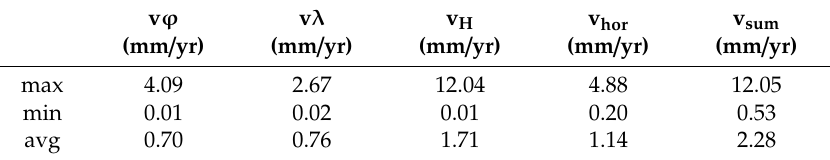
Table 3. The statistical value of the velocity components for the 1997–2015